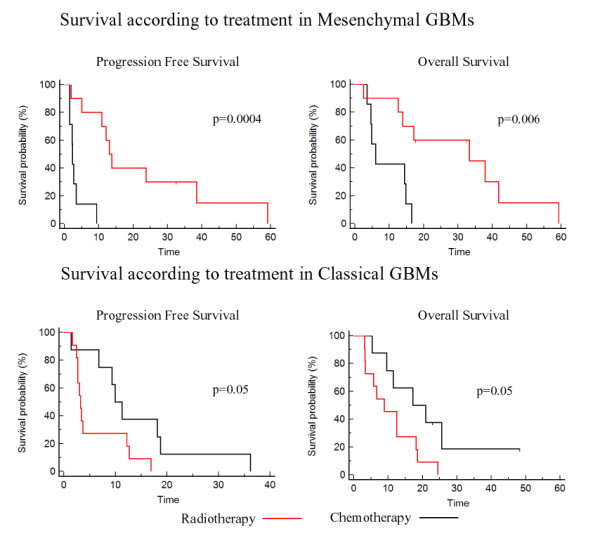
Survival according to treatment in mesenchymal and classical GBMs. Progression-free survival and overall survival according to treatment (radiotherapy = red, first-line chemotherapy = black) in the GBMs of the present study classified as mesenchymal or classical according to Verhaak et al.'s classes [10].